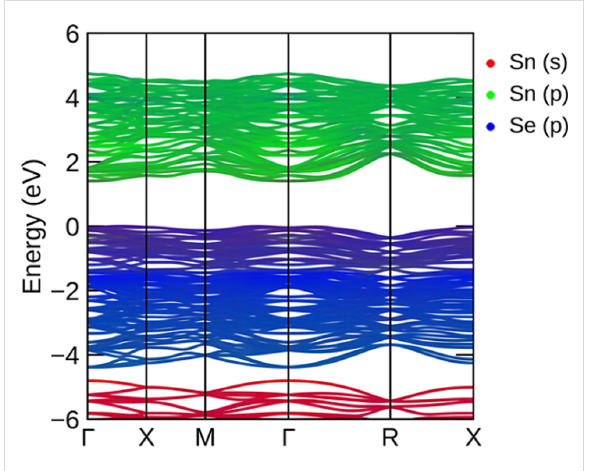
Figure 4: Projected band structure plot for the π -SnSe calculated by the meta GGA-mBJ